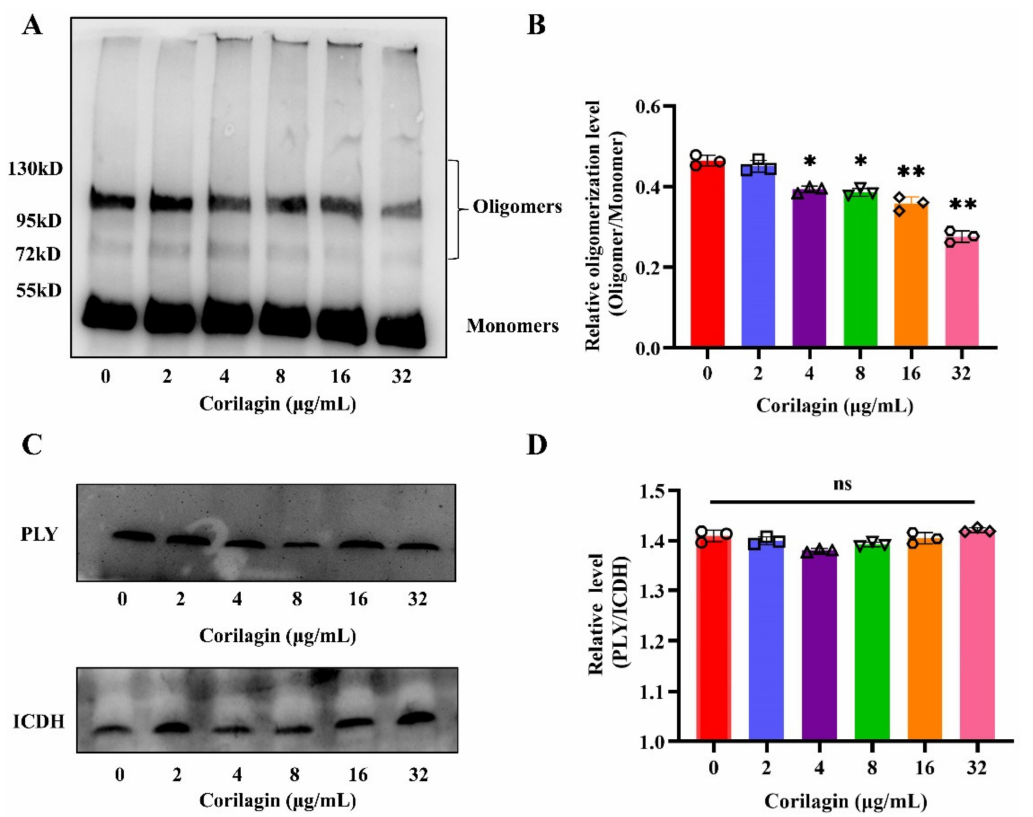
Figure 2. The formation of PLY oligomers was inhibited by corilagin. ( A ) Western blot analysis of purified PLY incubated with different concentrations of corilagin (0, 2, 4, 8, 16 and 32 µ g/mL). ( B ) The oligomerization level of PLY was quantitated by ImageJ software (* p < 0.05, ** p < 0.01). ( C ) PLY expression of S. pneumoniae D39 was verified by Western blot assay exposed to various concentrations of corilagin (0, 2, 4, 8, 16 and 32 µ g/mL). ( D ) The quantified assay of the expression level of PLY by ImageJ software (ns, no significant